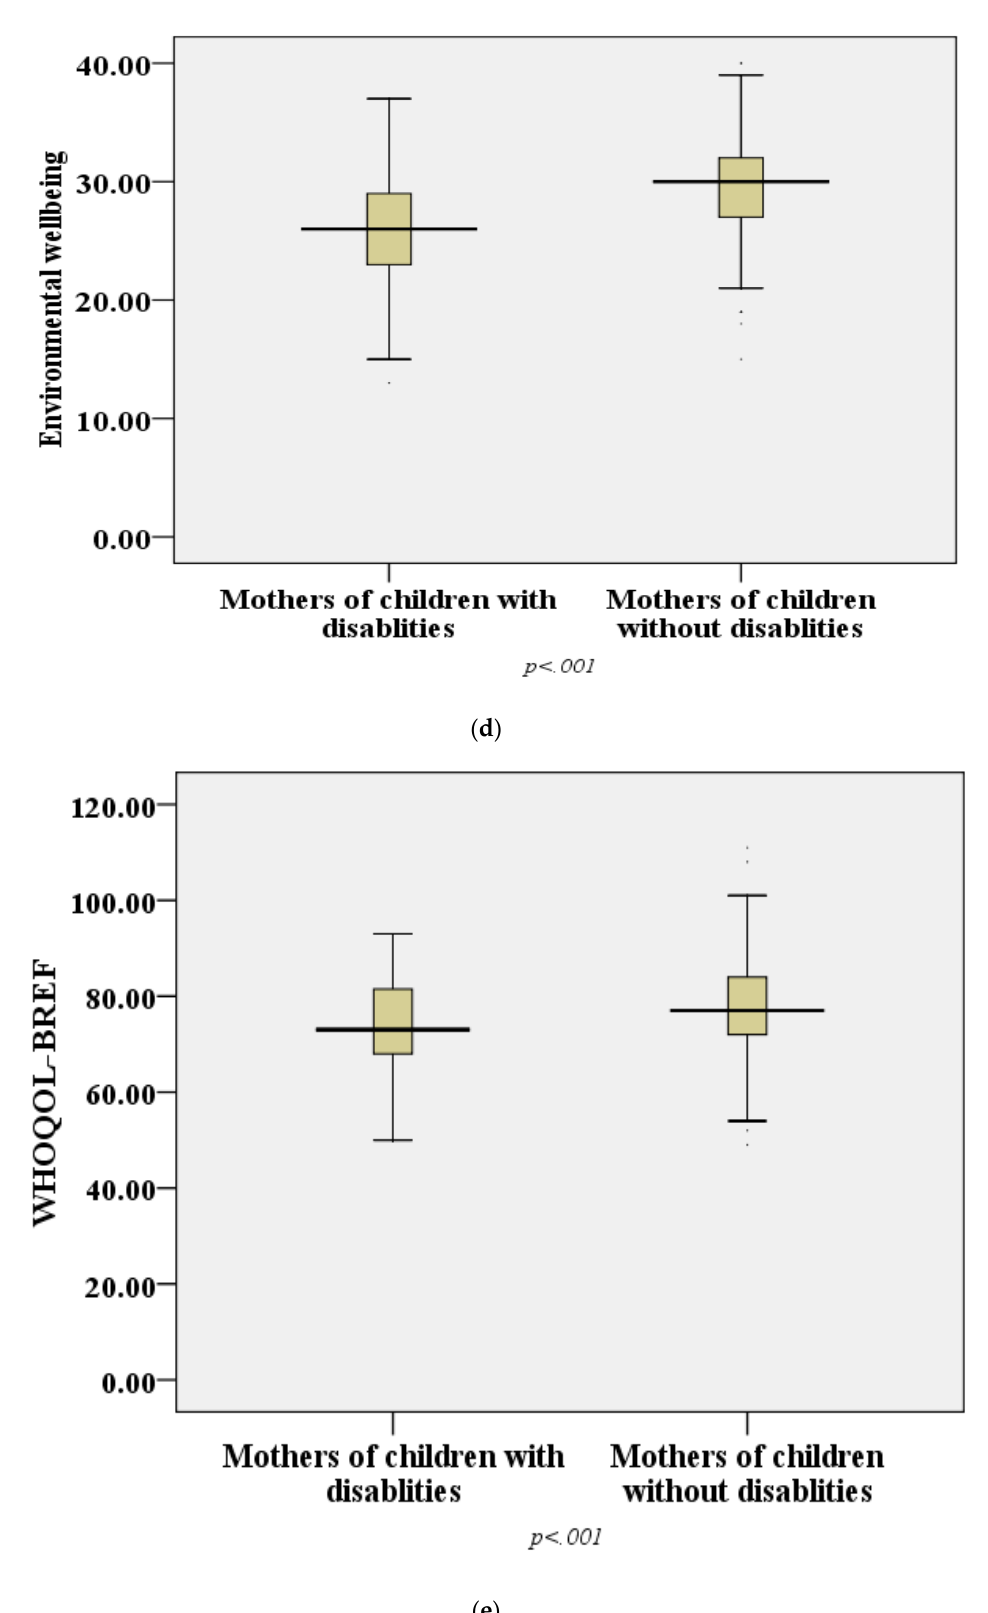
Figure 1. WHOQOL-BREF subscales among mothers of children with disabilities and mothers of children without disability during COVID-19 lockdown. ( a ) psychological health; ( b ) physical health domain; ( c ) social relations; ( d ) environmental health; ( e ) total QoL scores.